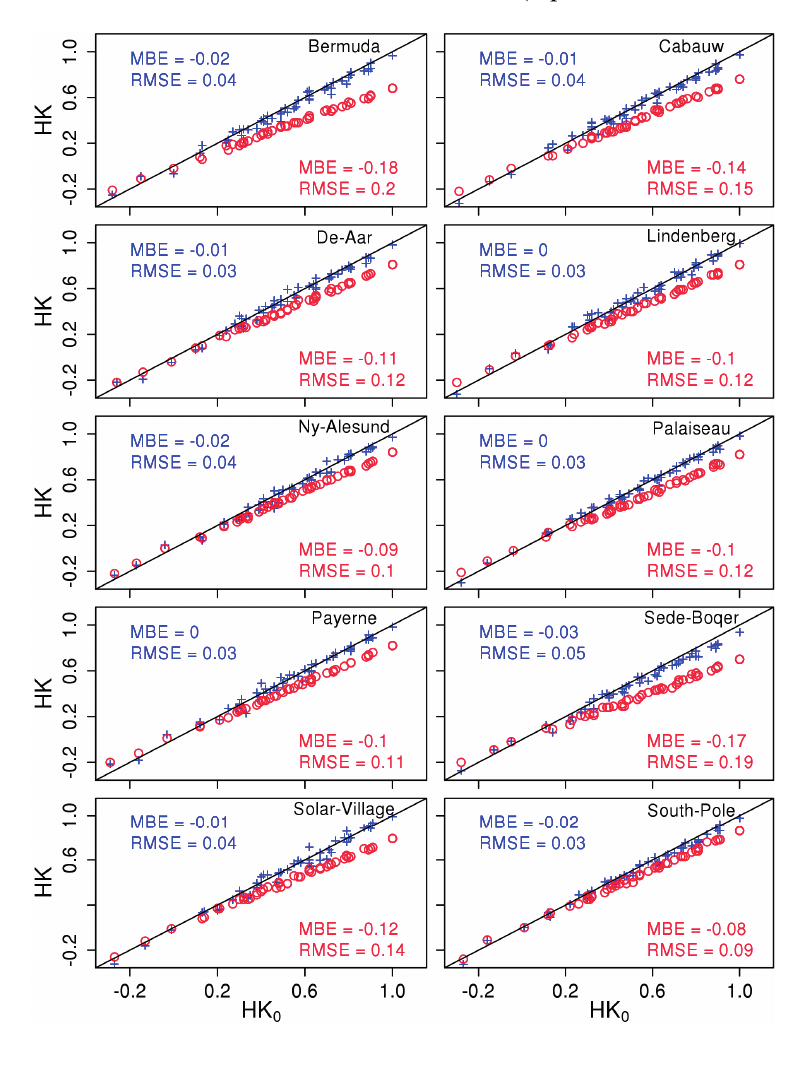
Figure 7. Validation results for artificial 3-year time series deg p,s of NOAA/AVHRR with eight overpasses per day against 3-h SYNOP at 10 BSRN sites. HK 0 stands for the unbiased skill score. The blue crosses represent the modeled skill score (HK mod ). The red circles represent the skill score derived by a standard validation, for which the closest SYNOP observation is used to validate the satellite-derived data (equal HK Δ t= 90m as for 3-h